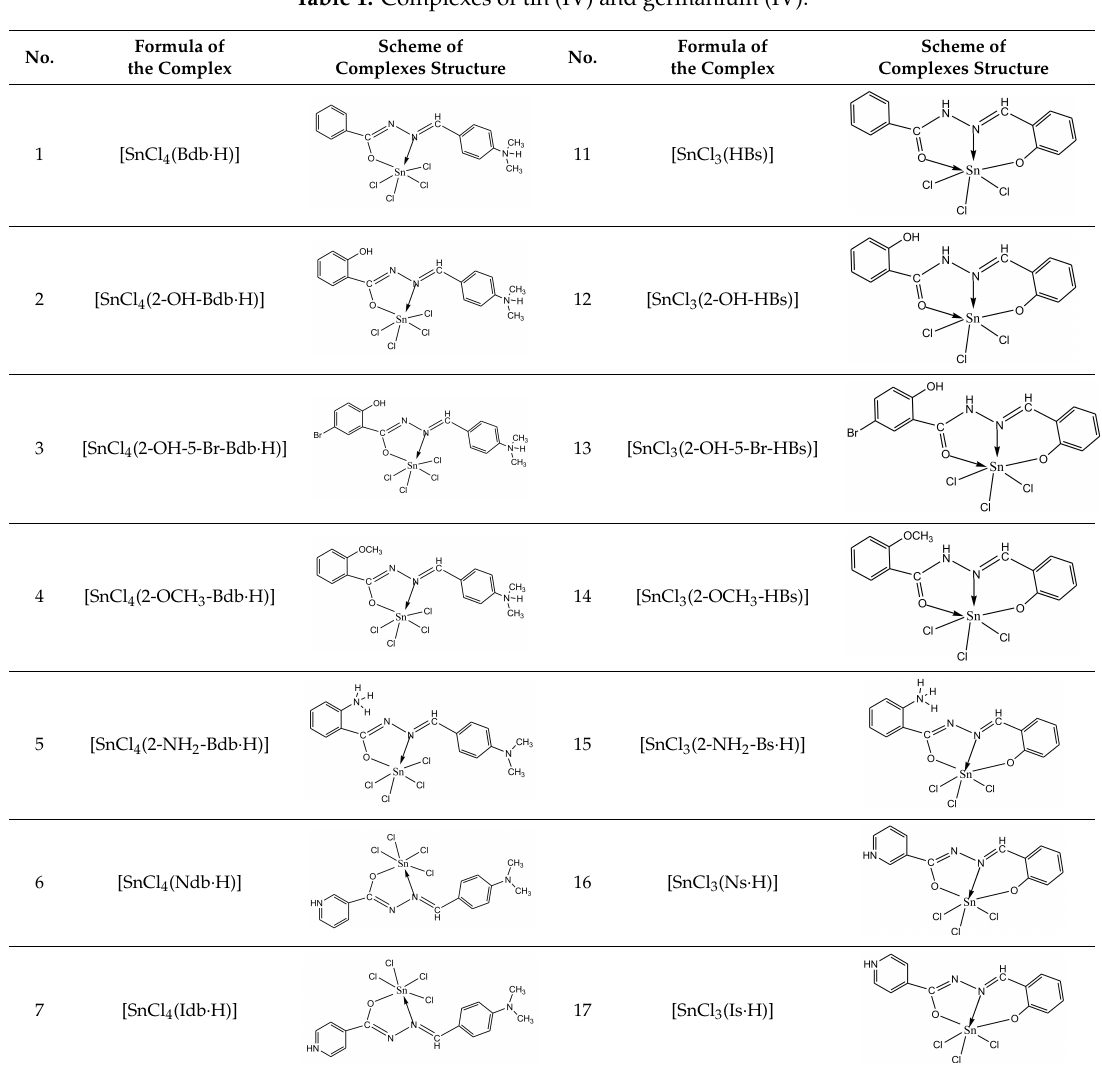
Table 1. Complexes of tin (IV) and germanium